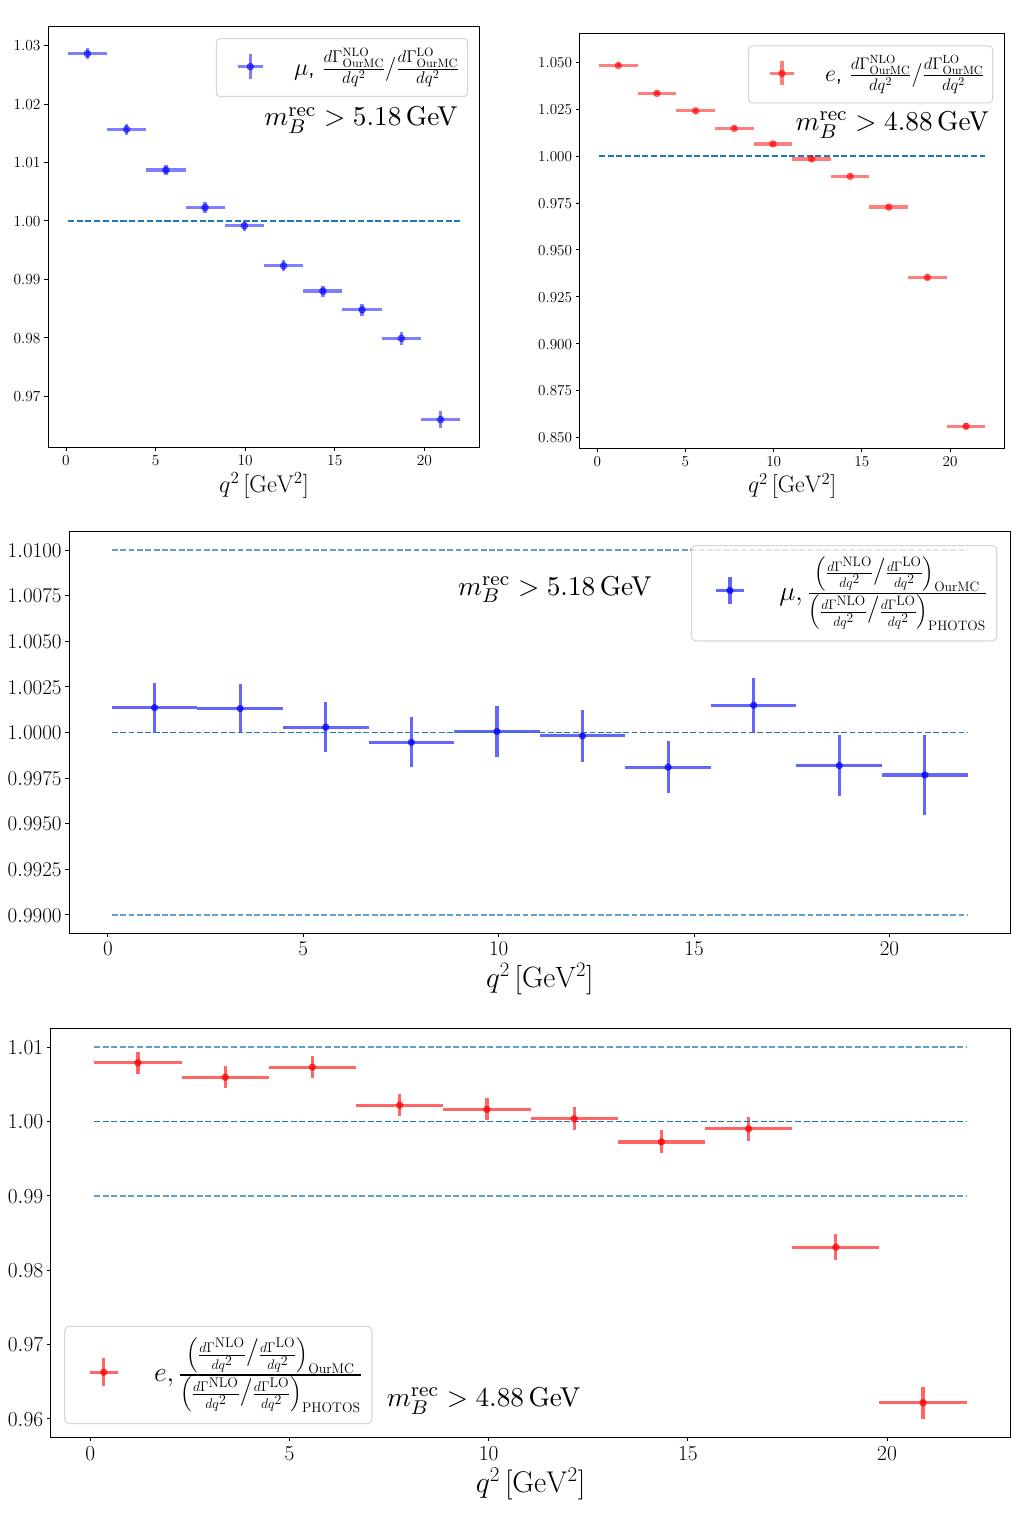
Figure 2 . Differential distributions in q 2 for the short distance transition only: the notation is the same as in figure